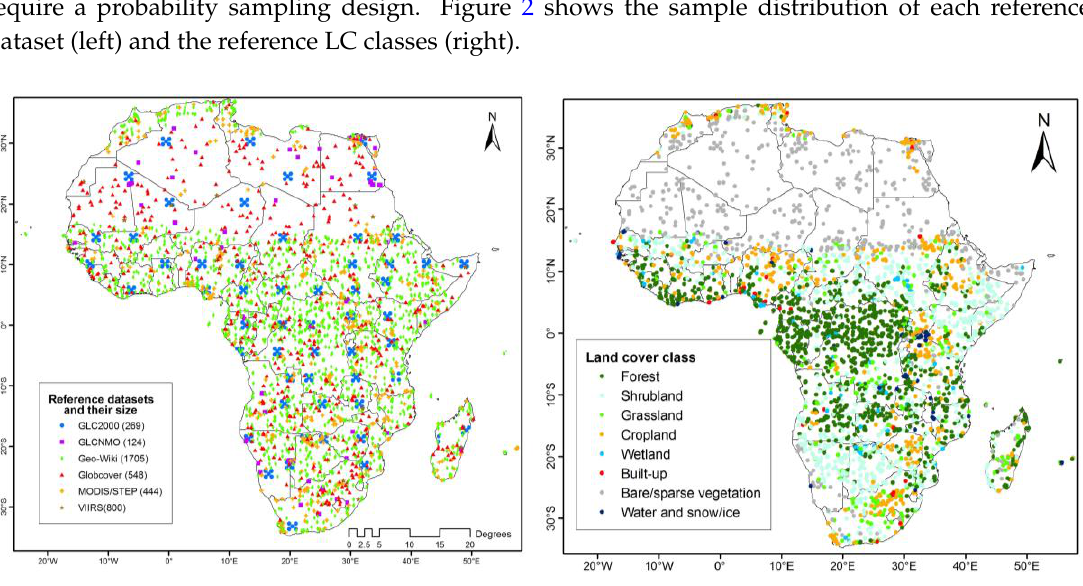
Figure 2. Spatial distribution of the reference datasets ( left ) and reference LC classes ( right ).